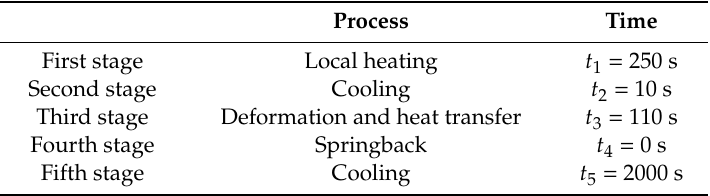
Table 1. Process and times at each stage.